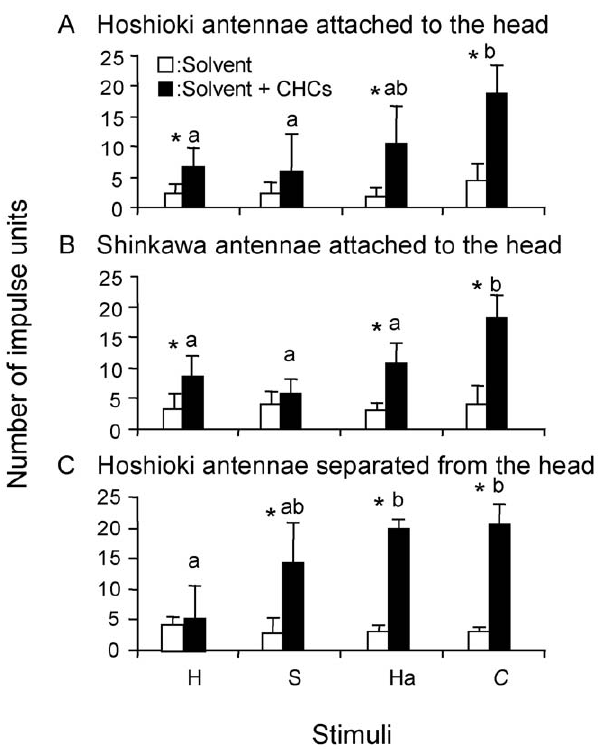
Figure 4. Blind experiments for impulse unit counting. Number of impulse units recruited by the stimulation with ‘‘Hoshioki’’ (H), ‘‘Shinkawa’’ (S), ‘‘Hakkenzan’’ (H) or C. japonicus CHCs ( C ) in the three types of CHC sensillar preparations; ( A ) ‘‘Hoshioki’’ CHC sensilla on the antenna attached to the heads; ( B ) ‘‘Shinkawa’’ CHC sensilla on the antenna attached to the heads; ( C ) ‘‘Hoshioki’’ CHC sensilla on the antenna detached from the head. white columns describe the response to the control solvent, 10 mM NaCl plus 0.1% Triton X-100. Different letters indicate significant differences by Tukey HSD test, respectively in plates A–C (A, F=7.55; B, F=12.34; C, F=9.60 at p , 0.05). Asterisks indicate significant differences from the control levels by t-test (p ,